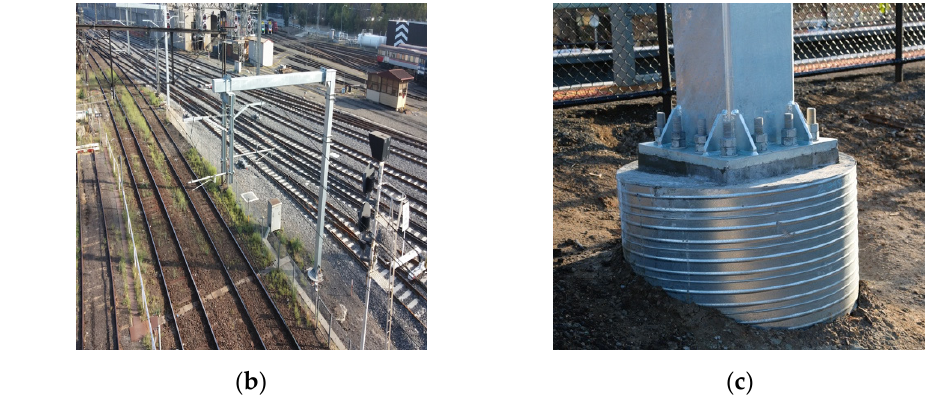
Figure 4. ( a ) historical riveted cantilever OWS, ( b ) a newly built cantilever OWS and ( c ) its founda- tion.